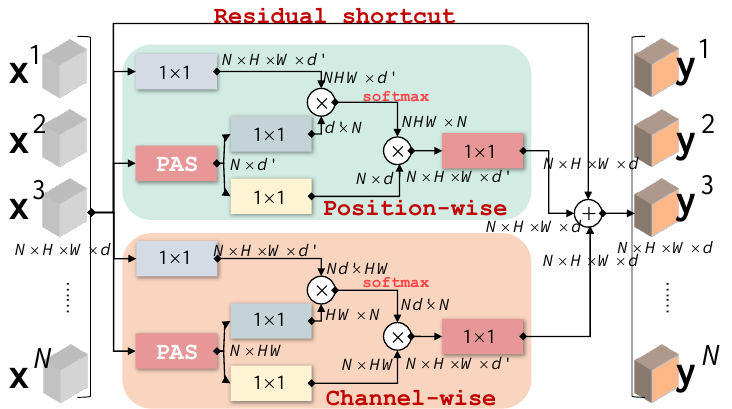
Figure 5. Inter-Region Relation (InterRR) for convolutional region features: given the features of a number of detected regions X = { x 1 , . . . , x N } , InterRR also computes the relations in position-wise and channel-wise but across